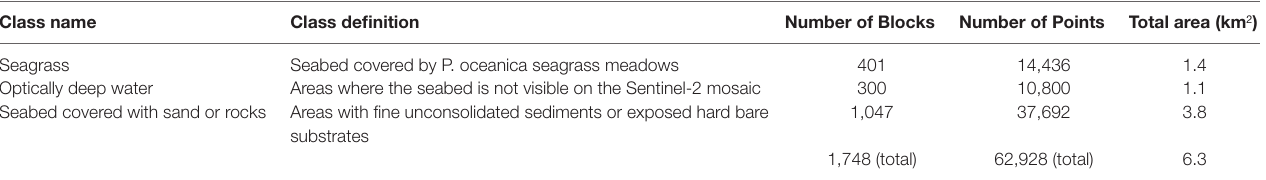
TABLE 1 | Name and definition of the human-labeled classes along with the number of designed training pixel blocks and